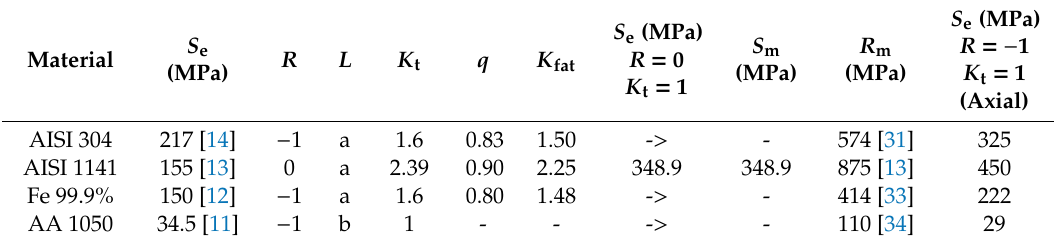
Stress concentration factors ( K t ) are determined from the numerical model of the notched sheet sample from [13] and vary between each material slightly due to di ff erent material properties defining their stress-strain responses. K t = 2.45 is the average value. Table A2. Experimental S e values of the investigated materials translated to the case defined by K t = 1 and R = −